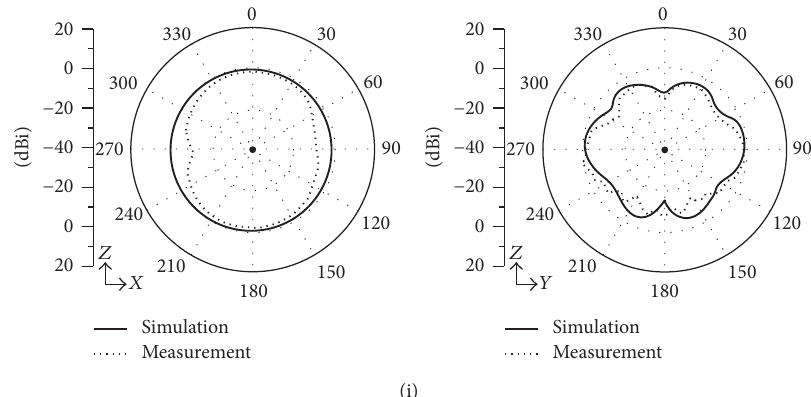
Figure 6: Simulated and measured XZ and YZ planes of antenna radiation patterns. (a) CUWB at 3.1 GHz. (b) CUWB at 6.5 GHz. (c) CUWB at 10.6GHz. (d) TRUWB at 3.1 GHz. (e) TRUWB at 6.5 GHz. (f) TRUWB at 10.6 GHz. (g) TUWB at 3.1GHz. (h) TUWB at 6.5 GHz. (i) TUWB at 10.6 GHz.